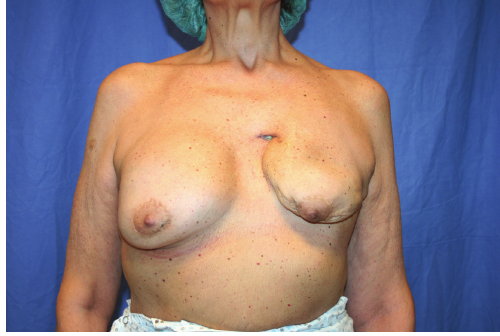
Figure 3: Breast fistula 20 days after fat graft.